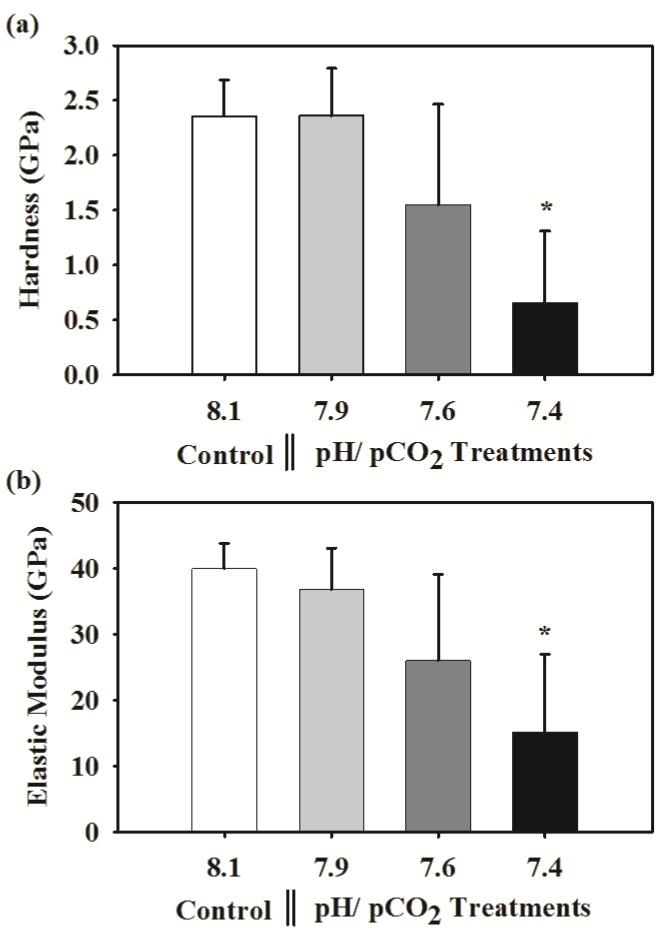
Effects of pH/pCO2 on the shell hardness and elastic modulus in the juvenile tubeworm, Hydroides elegans.Each bar represents the mean ± SD of 4 to 2 biologically independent measurements; i.e. n = 4 for control, n = 3 for the pH 7.9 and 7.6, and n = 2 for the pH 7.4. This uneven biological replicates across treatments was due to loss of samples during hardness measurement. However, the Dunnett test is robust and suitable for the comparison of the mean obtained from uneven sample size. The asterisk (*) shown on the bar indicates a significant difference between the control and the treatment according to the Dunnett's Post-hoc test (p<0.05).